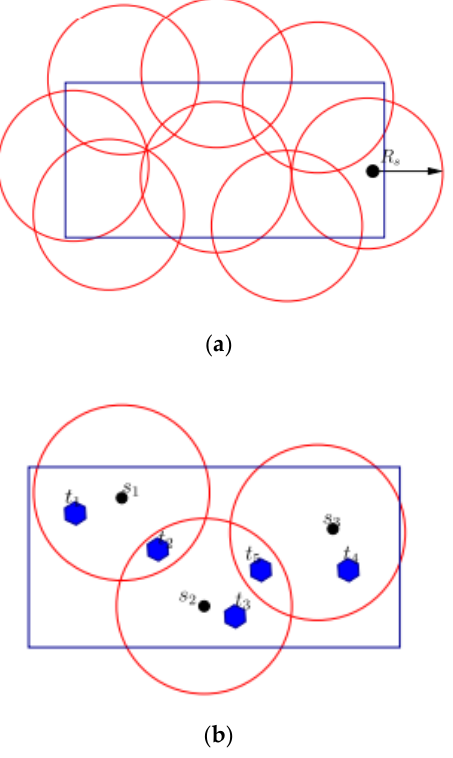
Figure 3. Coverage of the FoI. ( a ) Area coverage. ( b ) Target coverage [14].